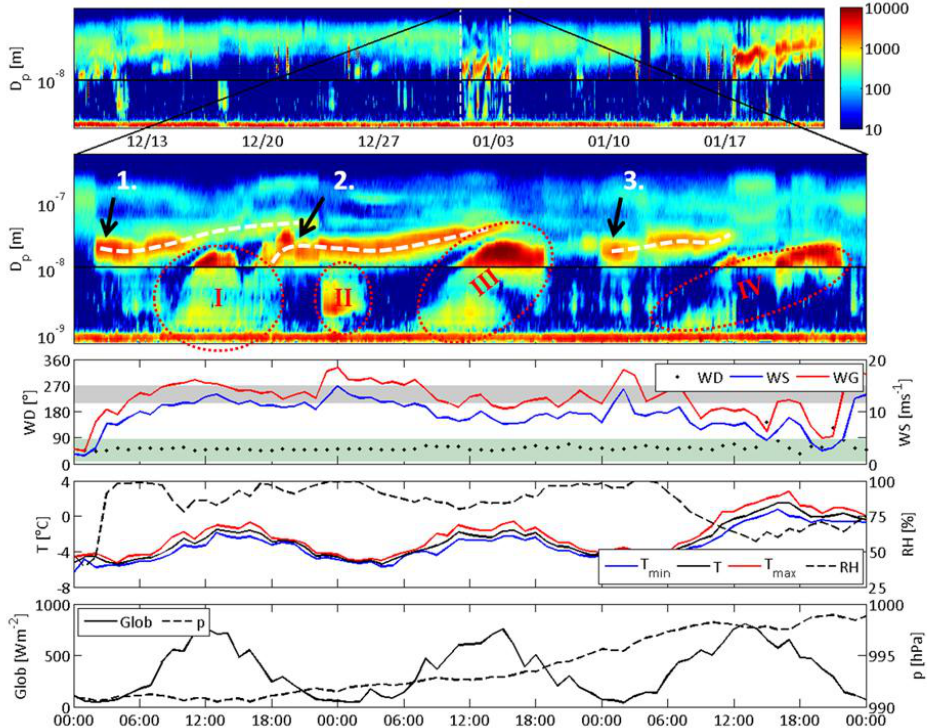
Fig. 3. Particle size distributions from AIS (negative polarity) and DMPS during the entire campaign (upper panel) and zoomed to the event period from 1 to 3 January 2010 (second panel). The colour scale is dN/dlog D p , unit cm − 3 . Local (I–IV) and regional NPF events (1–3) are also marked in the figure. The white dashed lines follow the growth of the regionally formed particles. Meteorological parameters (wind direction, speed and gust; average, minimum and maximum temperature as well as relative humidity; global radiation and pressure) during the event period are shown in the three lowermost panels. The shaded green and grey areas in the third panel show the pond (10–85 ◦ ) and contamination (210–270 ◦ ) sectors, respectively.